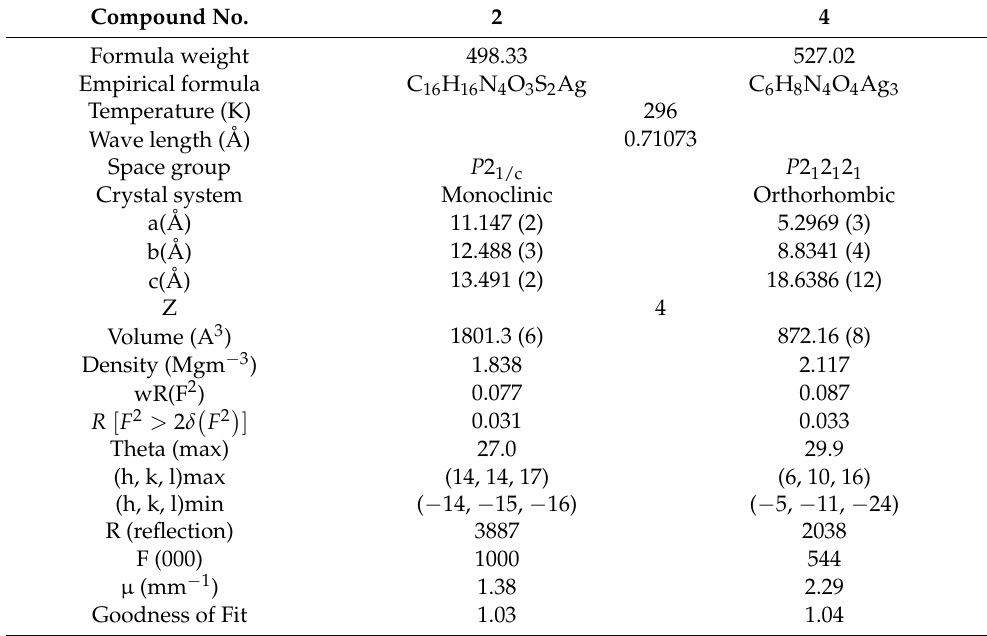
Table 2. Summarized parameters pertaining to crystal structure solution and refinement of com- pounds 2 and 4 .